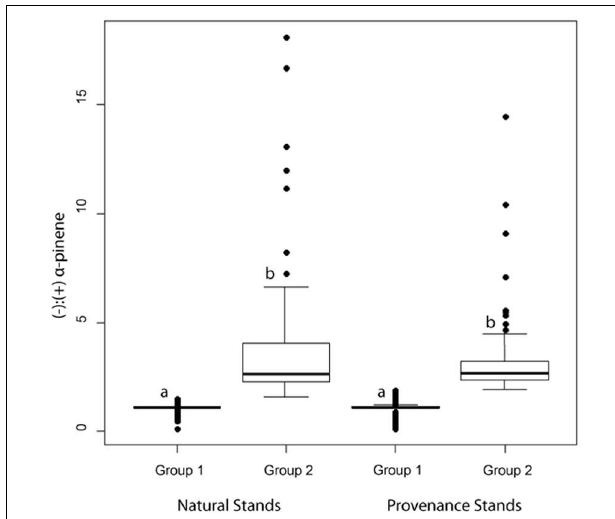
FIGURE 5 | Box and whisker plots of jack pine ( Pinus banksiana ) α -pinene groups as defined by a hierarchical cluster analysis. Boxes represent data between the first and third quartiles while the whiskers represent the range of data excluding outliers, represented by dots. Letters represent statistically significant differences at α = 0